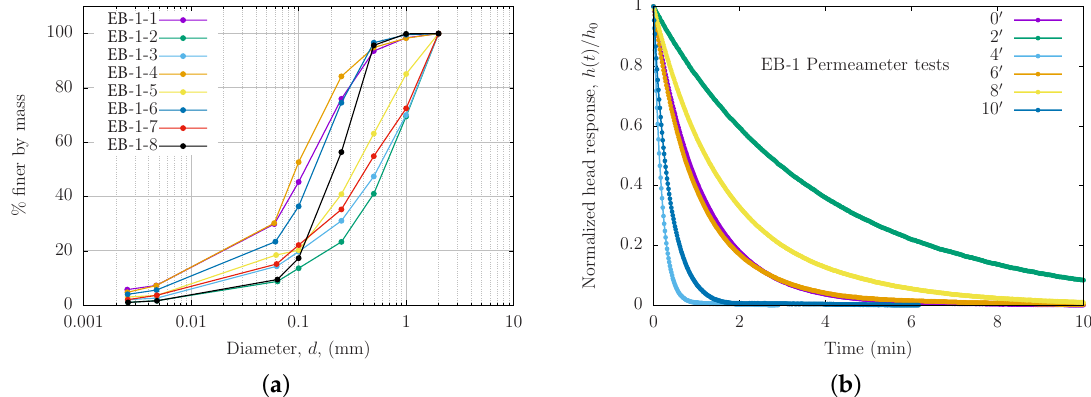
Figure 4. Examples of laboratory data collected during ( a ) particle size analyses and ( b ) falling-head permeameter tests performed on sediment from exploratory borehole